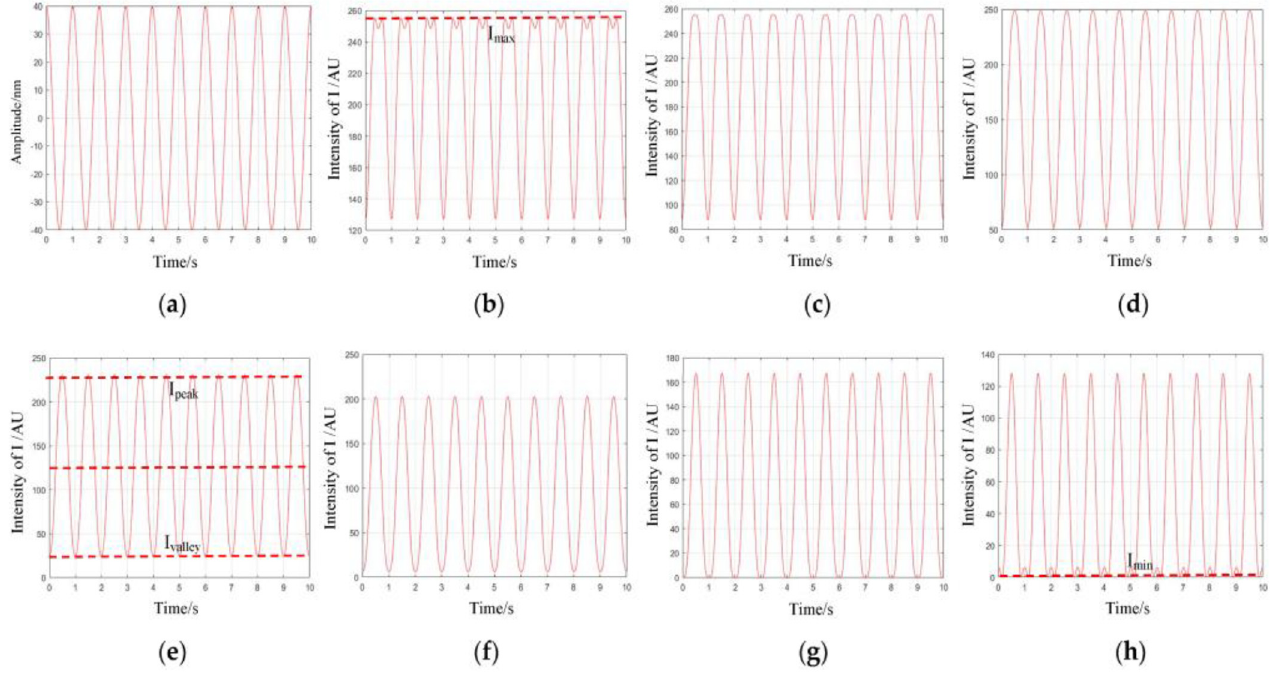
σ is − 3 π /10, − 2 π /10,